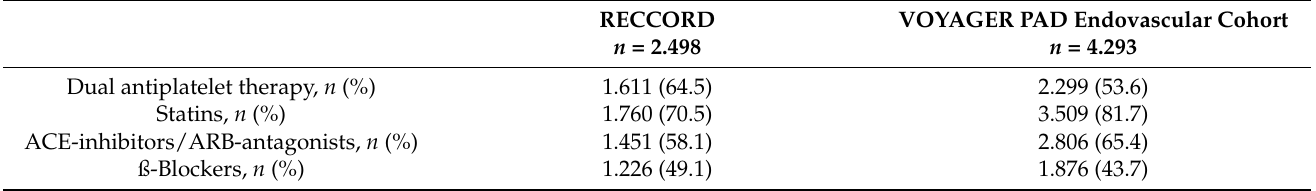
Table 2. Comparison of drug therapies between patients treated by EVR in the registry and the RCT. RECCORD n =